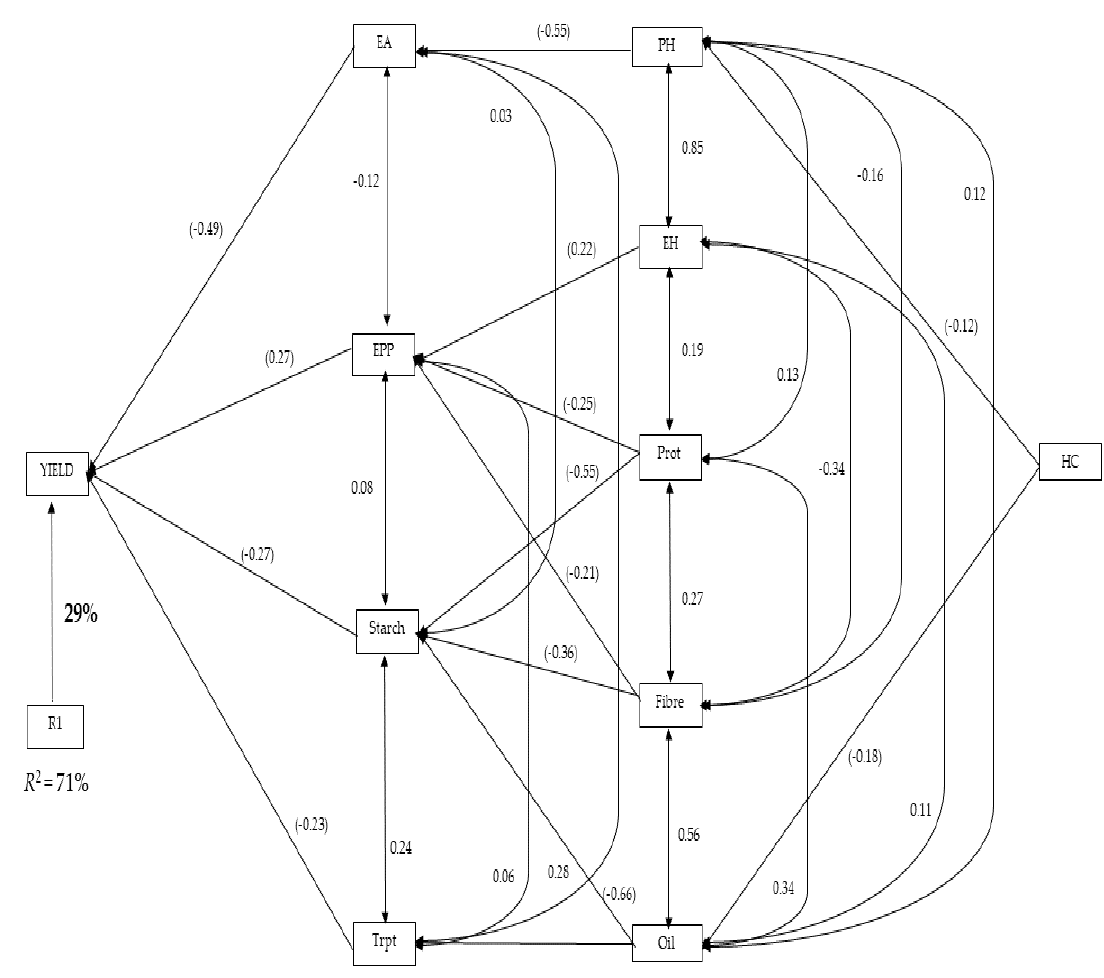
Figure 5. Path analysis showing the relationship of grain yield, agronomic and quality traits of 135 QPM and non-QPM maize hybrids: yield, grain yield; ER, ear rot; EPP, ear per plant, EA, ear aspect, HC, husk cover, ASI, anthesis-silking interval; EH, ear height; PH, plant height; DA, days-to-anthesis; Trypt, tryptophan; Prot, protein. Values in parentheses are correlation coefficients, and other values are direct path coefficients. R1 represents the residual effects.